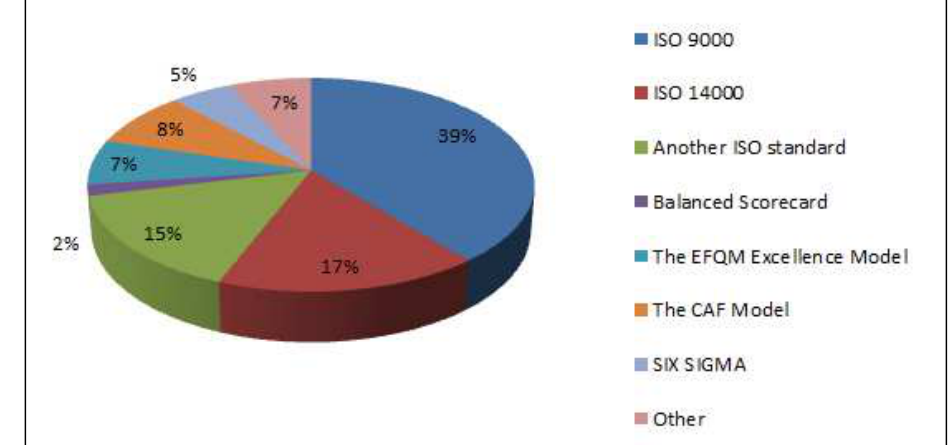
Fig. 11 Results of question 12: What tool or quality model was implemented in your organisation before your participation in the